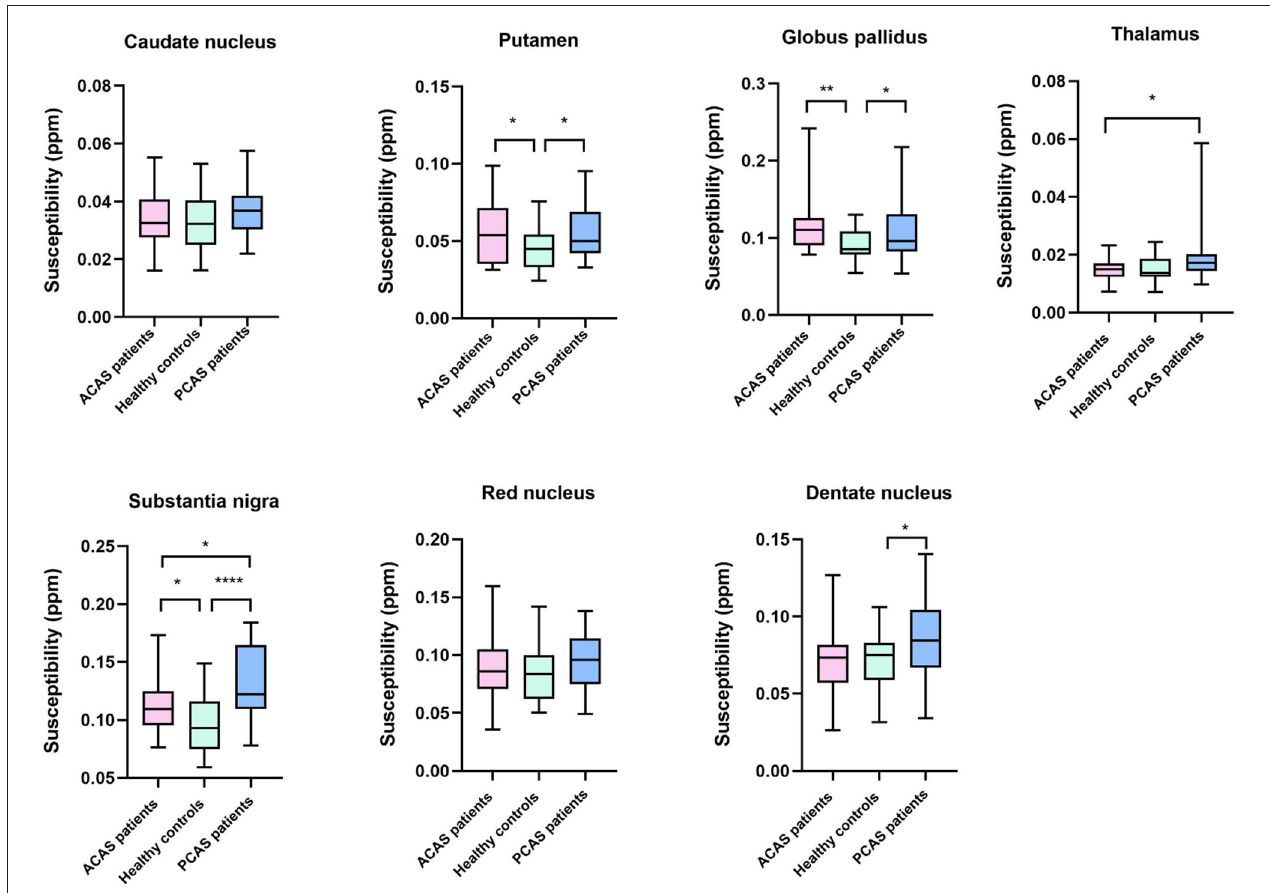
FIGURE 2 | Box-and-whisker plots were used to compare the susceptibility of seven gray matter nucleus subregions across healthy controls, anterior circulation artery stenosis (ACAS) patients, and posterior circulation artery stenosis (PCAS) patients. Significant difference: * P < 0.05; ** P < 0.01; **** P < 0.0001.